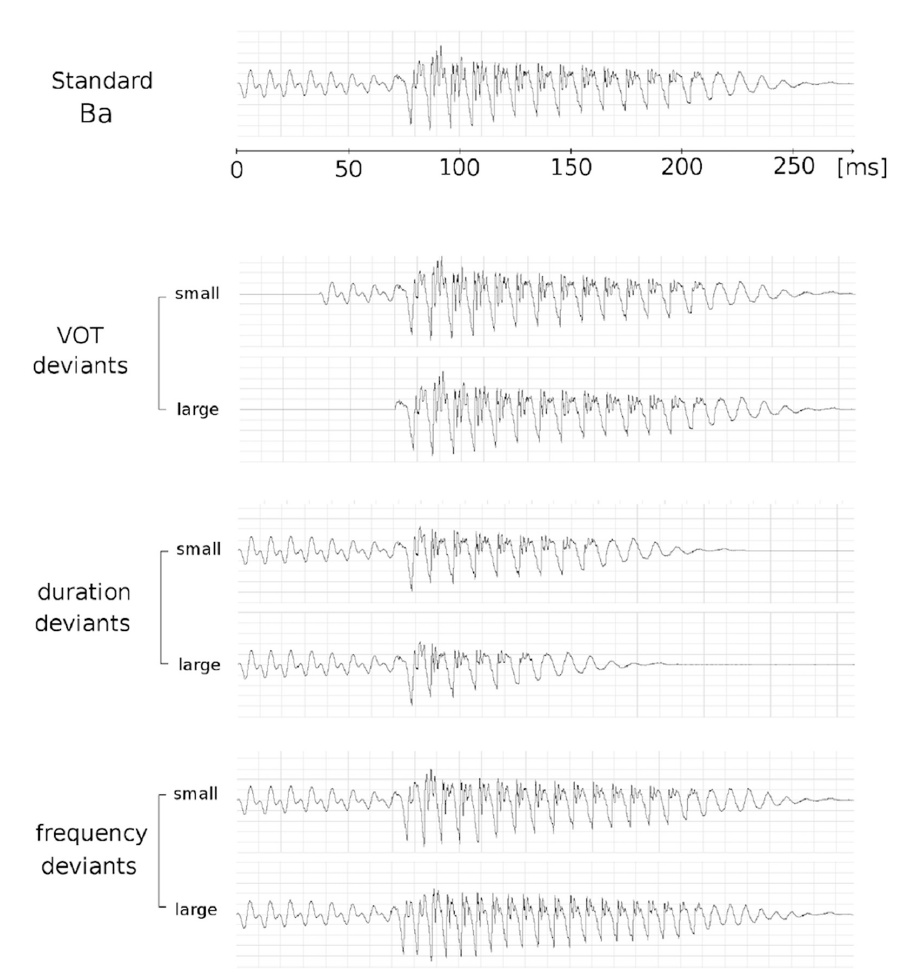
Figure 1. Illustration of the stimuli used in the experiment. Standard stimulus / Ba / (Voice Onset Time (VOT): − 70 ms, vowel duration: 208 ms, total duration: 278 ms and F0: 103 Hz); VOT deviant stimuli (vowel duration and F0: same as for / Ba / but VOT for large deviant stimulus = 0 ms ( / Ba 0 ms / ) and VOT for small deviant stimulus = − 40 ms (was / Ba − 40 ms / ); duration deviant simuli (VOT and F0: same as for / Ba / but vowel duration for the large deviant stimulus = 128 ms and for the small deviant stimulus = 158 ms; and frequency deviant stimuli (VOT and vowel duration: same as for / Ba / but F0 for the large deviant stimulus = 154 Hz and for the small deviant stimulus = 117 Hz).